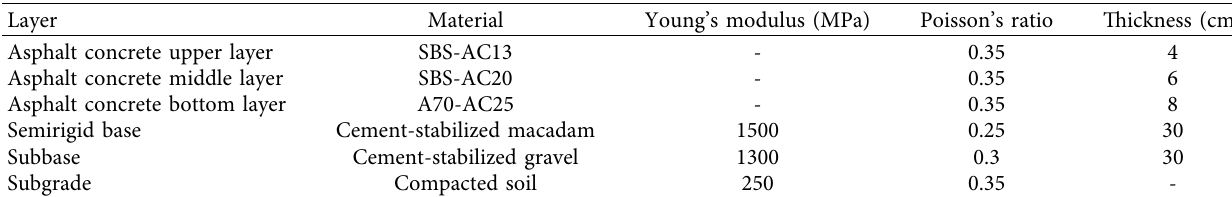
Figure 1: Pavement model. (a) Overall structure diagram of semirigid base asphalt pavement. (b) Mid-section along the Z axis. Table 1: Properties of